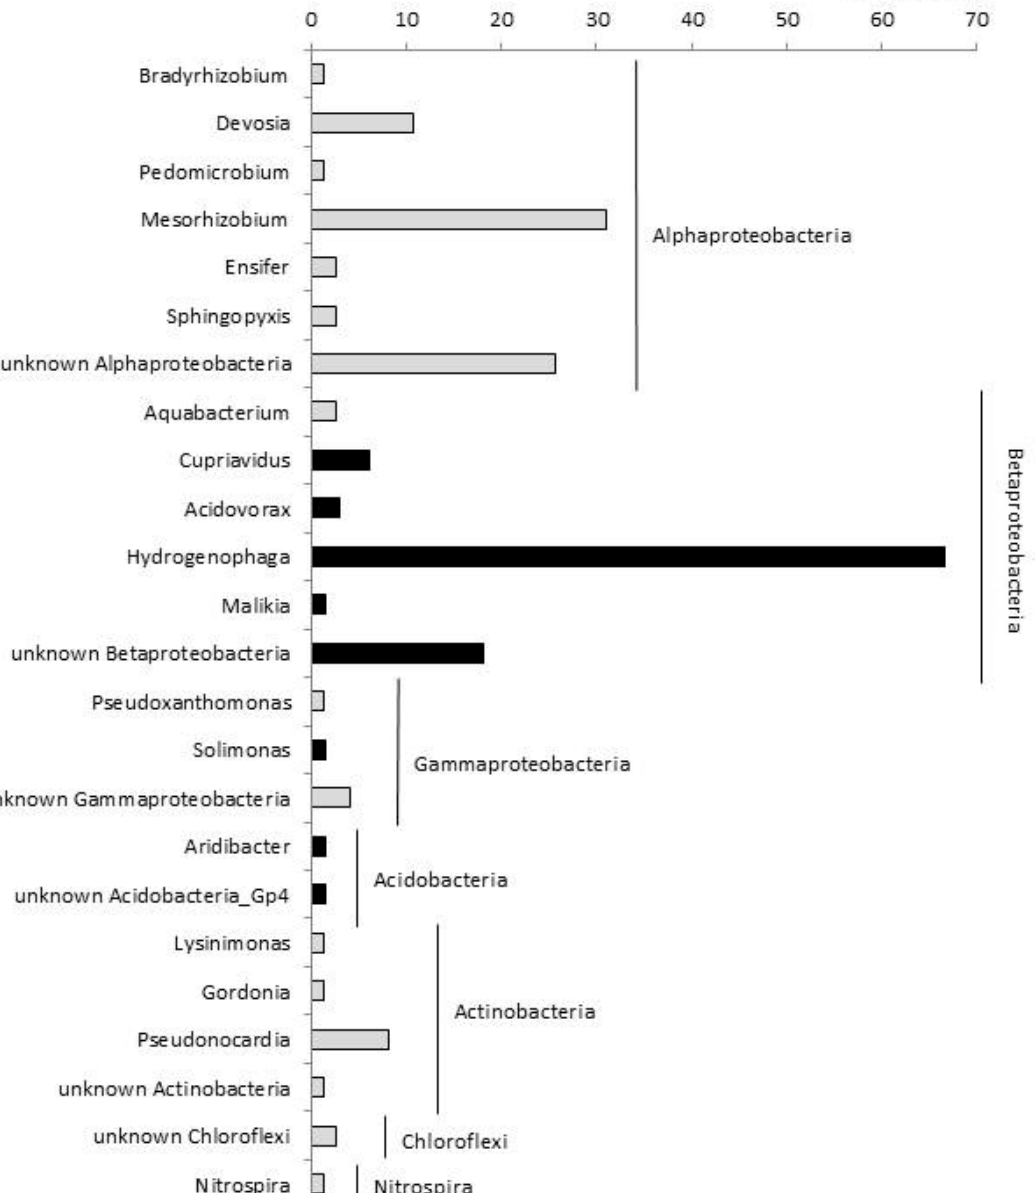
Figure 2. Comparison of PW and UW ETBE-enrichment subculture communities by 16S rRNA gene sequencing (based on 66 and 74 clones, respectively). Bars represents per cents of recovered clones from PW (black) and UW (white) ETBE-enrichment subcultures affiliated to the indicated bacterial taxa.